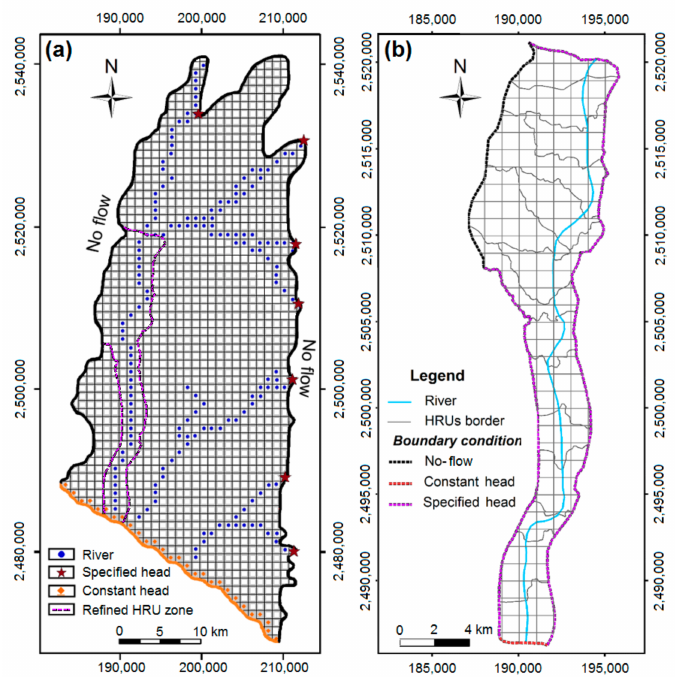
Figure 4. The conceptual model and boundary conditions for the basin-scale model and the sub- model: ( a ) the basin-scale model includes the entire Pingtung Plain groundwater basin, ( b ) the sub-model focuses on the downstream area of the Kaoping